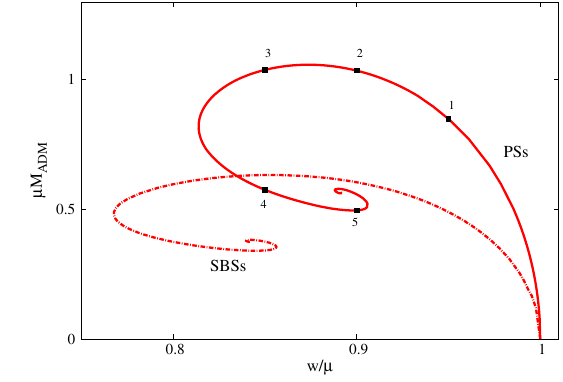
Fig. 13 Comparison of Proca solutions with boson stars. The ADM mass of spherical Proca solutions (solid) and scalar BS solutions (dashed) are shown versus oscillation